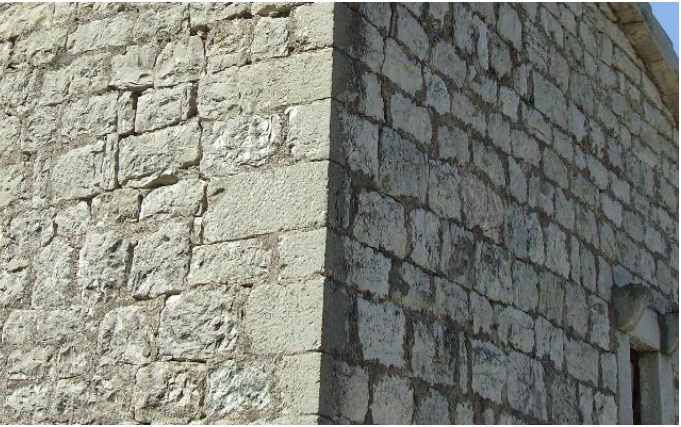
Figure 14. The corners of the house were constructed using extended blocks. Figure 14. Wooden floor constructions attached to the walls with